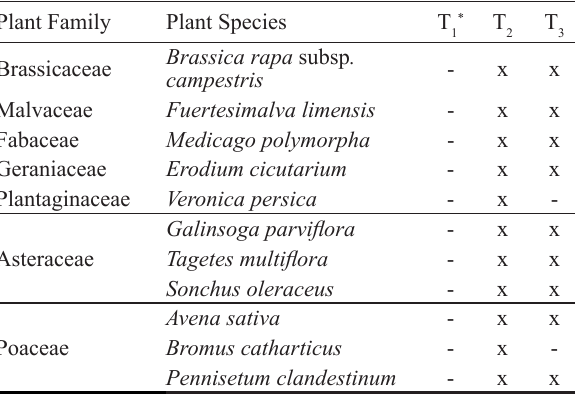
Table 3. Diversity of weeds recorded at 120 days after seeding of the mixed pasture sown in the Mantaro Valley, Junín. February 2013.